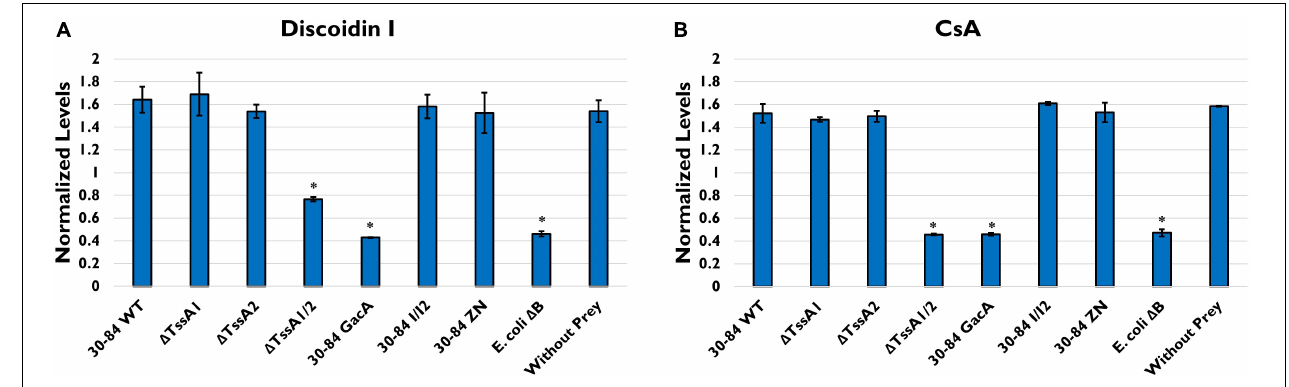
FIGURE 6 | Levels of two starvation markers in Dictyostelium discoideum . D. discoideum AX2 cells were incubated in PBM with the indicated prey strains (30–84 WT, (cid:49) TssA1, (cid:49) TssA2, (cid:49) TssA1/2, 30–84 GacA, 30–84 I/I2, or 30–84 ZN and E. coli (cid:49) B) or without prey (negative control) for 24 h. Western blots were stained with anti-Discoidin I, anti-CsA, or anti-beta-Actin antibodies. Graphs show the levels of (A) Discoidin I or (B) CsA normalized to total actin. Values are mean and standard error of 2 independent experiments. * Indicates p < 0.01 compared to D. dictyostelium AX2 control (Unpaired t -tests, Welch’s